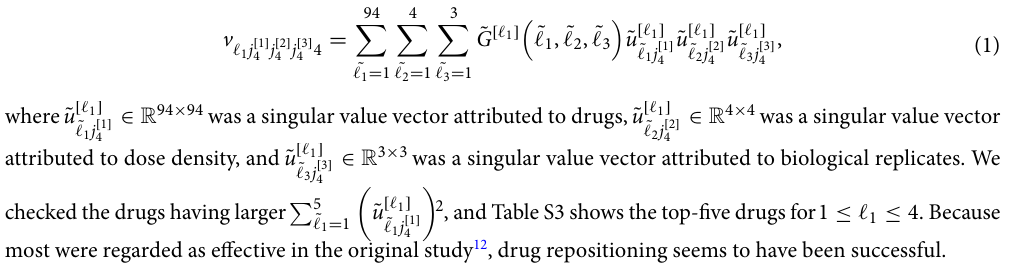
Fig. S4. Although we have considered scenarios up to ℓ 1 = 5 , v ℓ Thus, as expected, the data show correlations between gene expression profiles of AD and ABCC1 overexpression through TD. We selected u ℓ 1 i , 1 ≤ ℓ 1 ≤ 5 by investigating G (ℓ 1 , ℓ 2 , ℓ 3 ) in Eq. (8) and fixing ℓ 2 ∈ { 1, 3, 4, 5 } (see Table S7). P